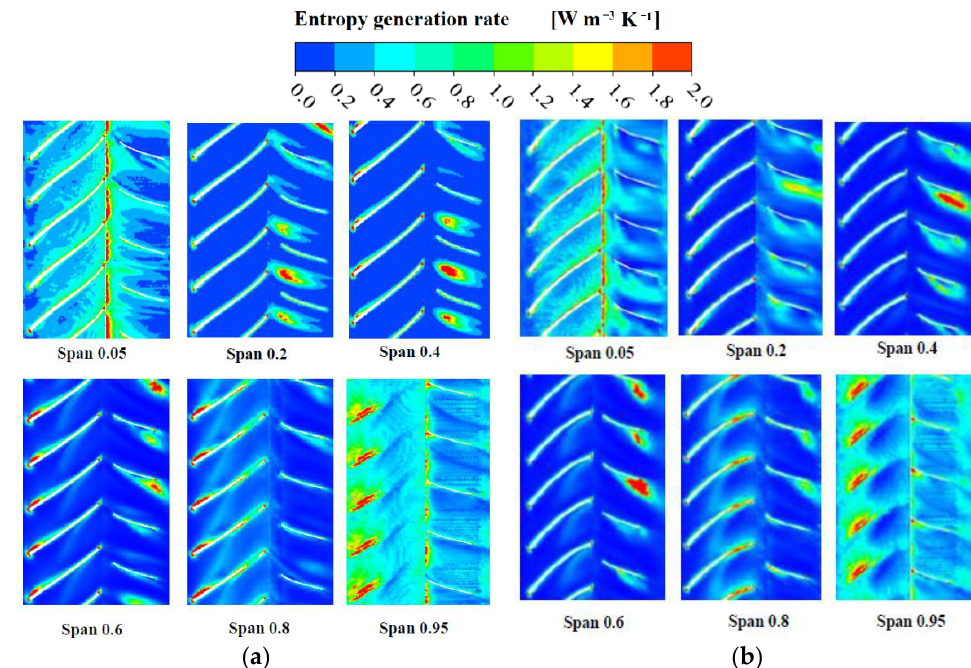
Figure 13. Different leaf height sections.